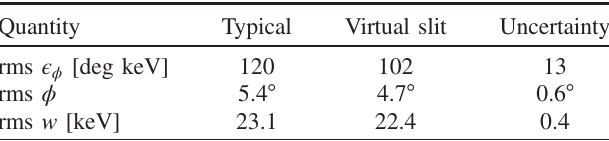
Table VIII compares rms for a “ typical ” phase space measurement with the reconstruction using the virtual slit technique. Note that there is still uncorrected point-spread from the internal BSM optics, but at rms 0.9° this leads to a much smaller error than from the energy